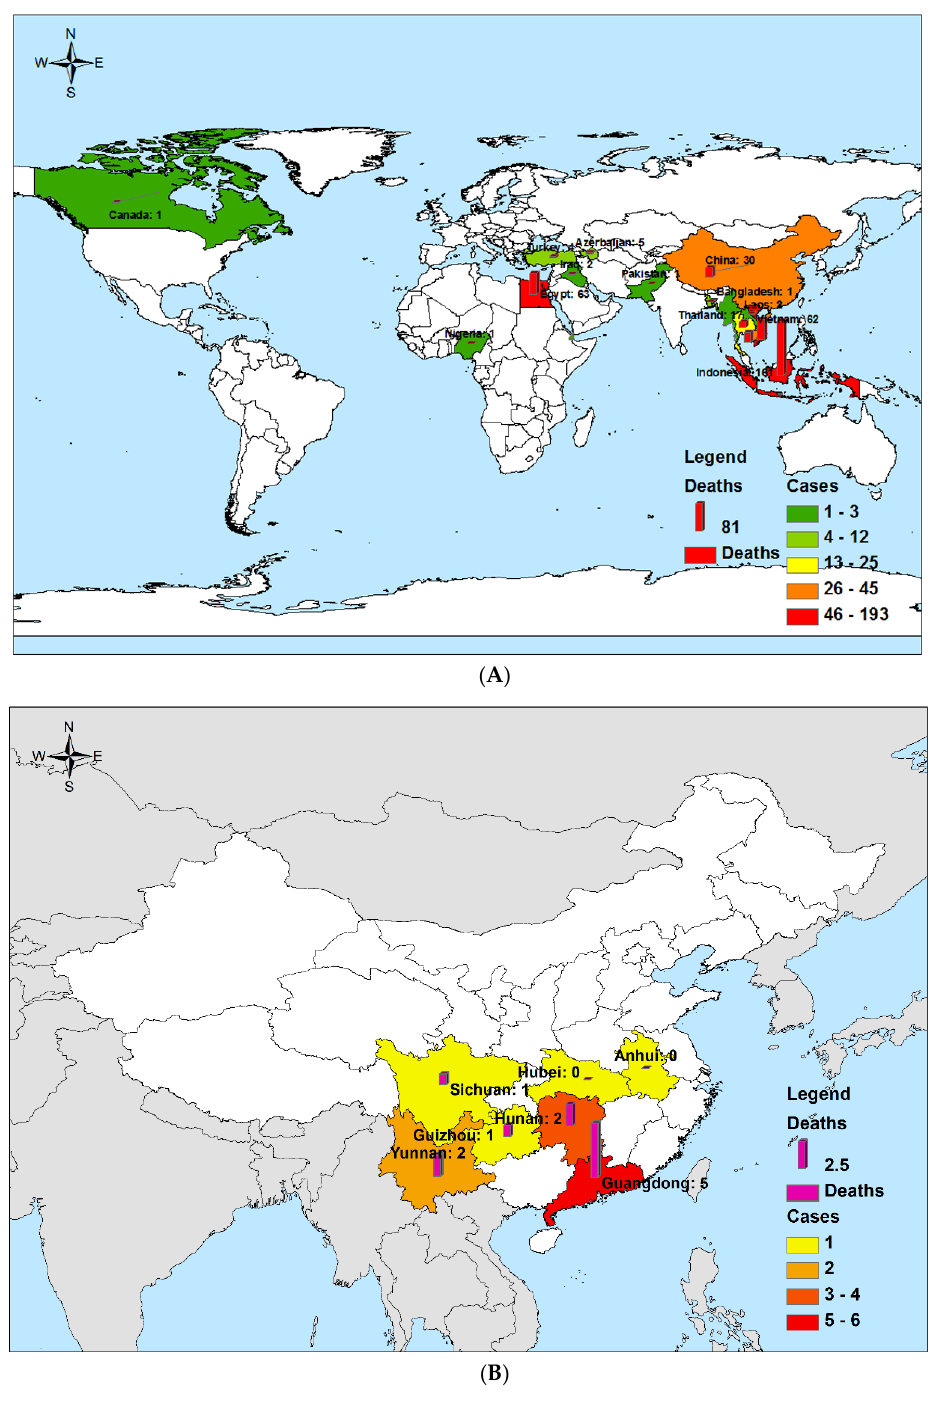
Figure 1 . Cont . Figure 1.